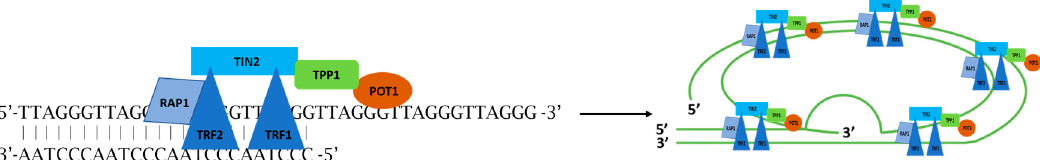
Figure 1. Telomeres are nucleoprotein structures composed of double-stranded short repeated sequences ending in a single-stranded G-rich overhang. Telomeric DNA is coated by specialized proteins that form the so-called shelterin complex. This group of proteins comprises six components: three DNA-binding proteins and three proteins that act as adaptors and mediate interactions among components. TRF1 and TRF2 bind the double strand DNA, while POT1 accumulates at the single-stranded G-rich overhang via TPP1 to protect telomeres. TPP1 connects with TIN2 that plays a role in stabilizing the shelterin complex through simultaneous binding with TRF1, TRF2 and TPP1. RAP1 facilitates the function of TRF2 and improves protection of telomeres through the formation of telomeric loop, T-loop. TRF1, telomere repeat binding factor 1; TRF2, telomere repeat binding factor 2; POT1, protection of telomeres protein 1; TPP1, abbreviation derived from TINT1/PTOP/PIP1; TIN2, TRF interacting nuclear factor 2; RAP1, Repressor/activator protein 1.